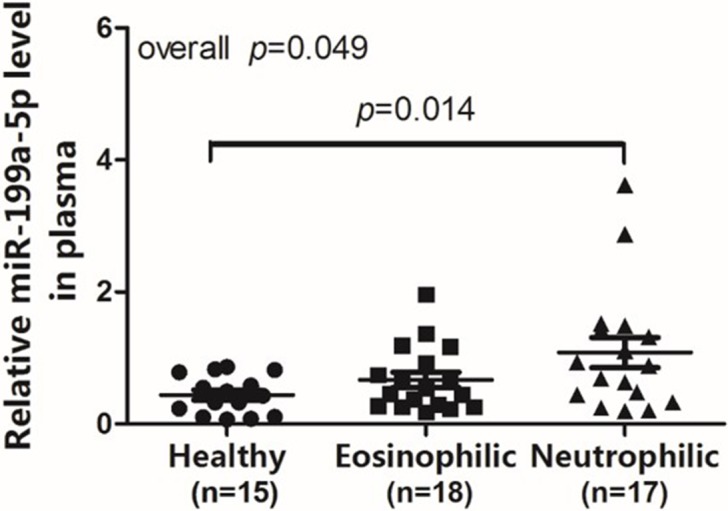
Relative miR-199a-5p levels in the plasma of different groups.Normalized miR-199a-5p expression levels in the plasma of different inflammatory phenotypes and healthy controls. miR-199a-5p expression levels were normalized to U6.